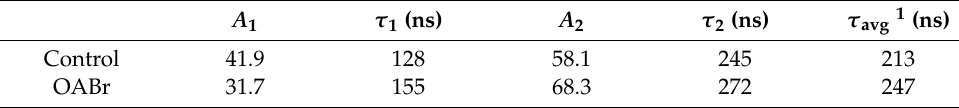
Table 2. Time-resolved PL parameters extracted from Figure 3b.